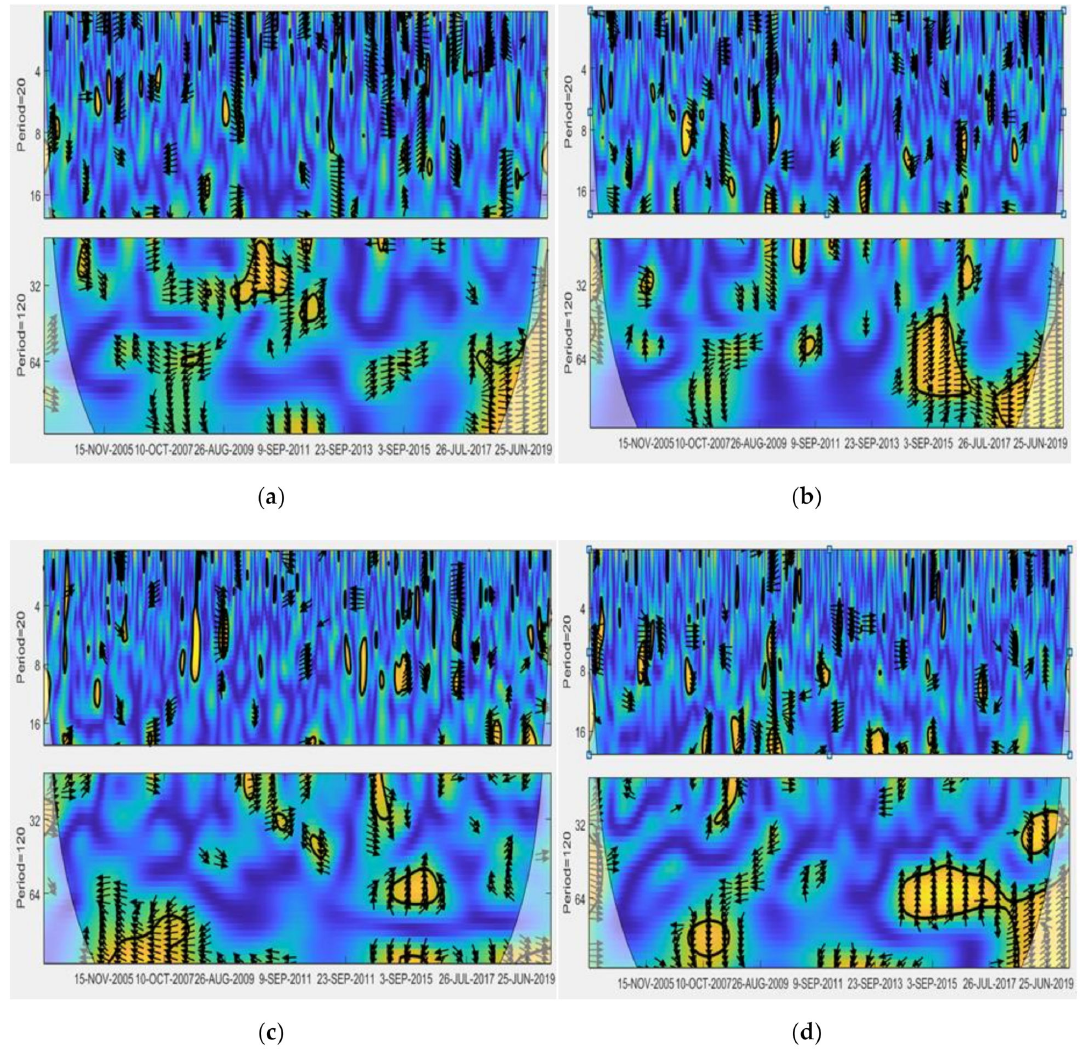
Figure 5. The long-term and short-term wavelet coherence of crude oil price volatility and stock market during panic. ( a ) US stock market, SP500; ( b ) Japanese stock market, N225; ( c ) mainland China’s stock market, SSEC; ( d ) Hong Kong stock market,